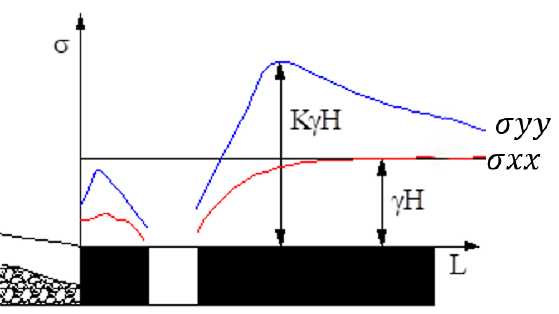
Figure 8. Stress distribution diagram of mining roadway surrounding rock.